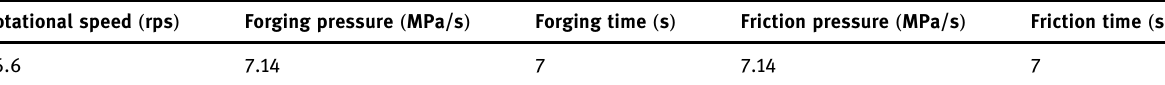
Table 3: Optimized RFW parameters used to develop rod - to - plate joint Rotational speed ( rps )